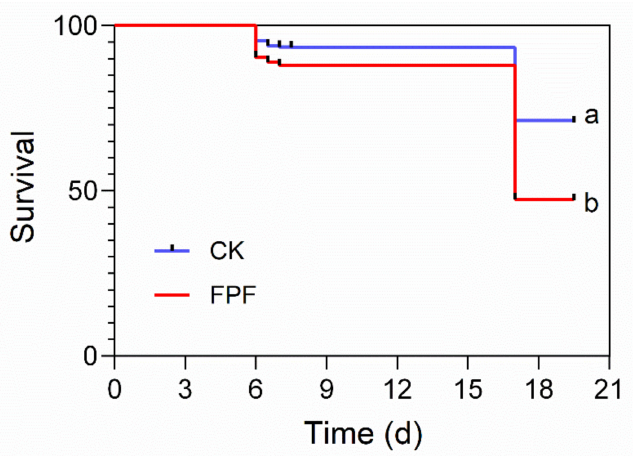
Figure 1. Total survival of honey bees exposed to flupyradifurone (FPF) during larval development ( n = 4 replicates of 130 larvae/replicate). Different letters between the curve lines represent significant differences (Log Rank test, p < 0.001).